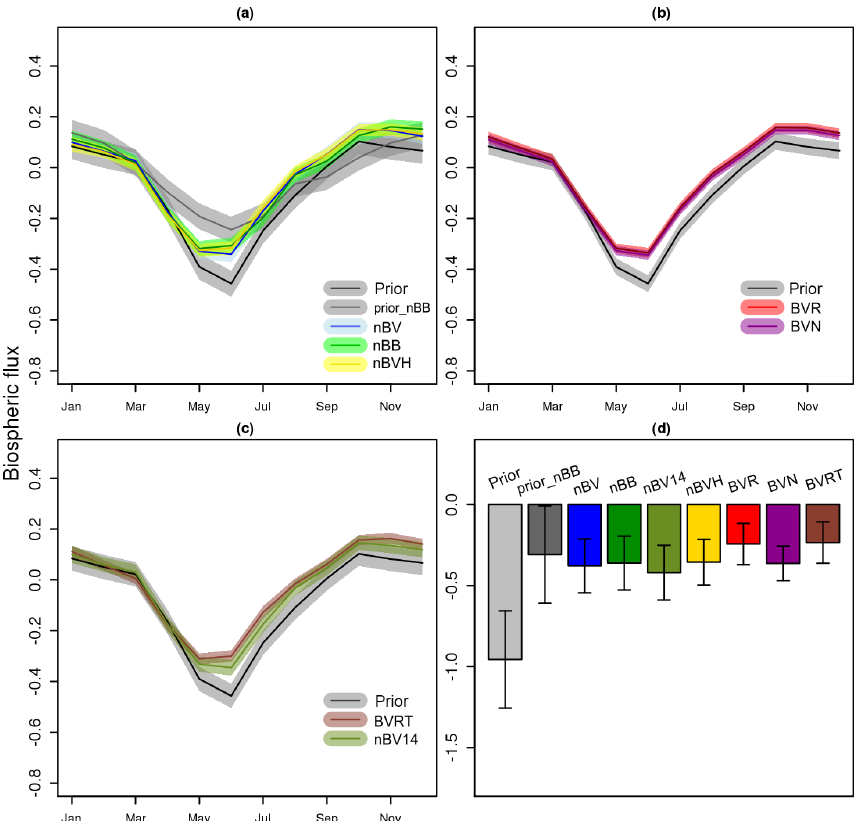
Figure 5. Monthly and annual (d) biosphere fluxes integrated over the domain. Panel (a) shows the nBV, nBB and nBVH cases, panel (b) shows the BVR and BVN cases, and panel (c) shows the BVRT and nBV14 cases. Note that all inversions share the same annual prior uncertainty but monthly prior uncertainties differ. Units are in GtCmonth − 1 and GtCyr − 1 for monthly and annual fluxes,